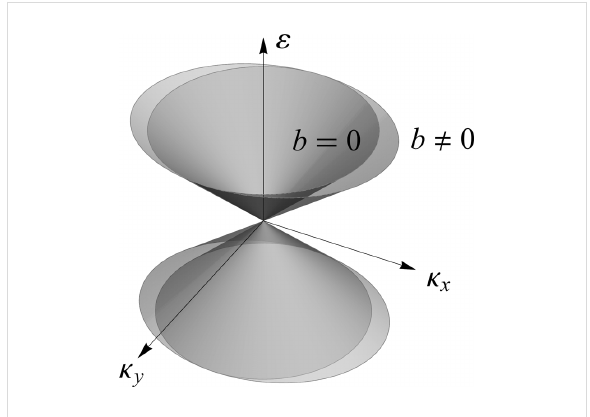
Figure 2: Dirac cones with, b ≠ 0, and without, b = 0, a magnetic field applied. The original cone is distorted along the x -direction and the Fermi velocity, i.e., the slope, becomes